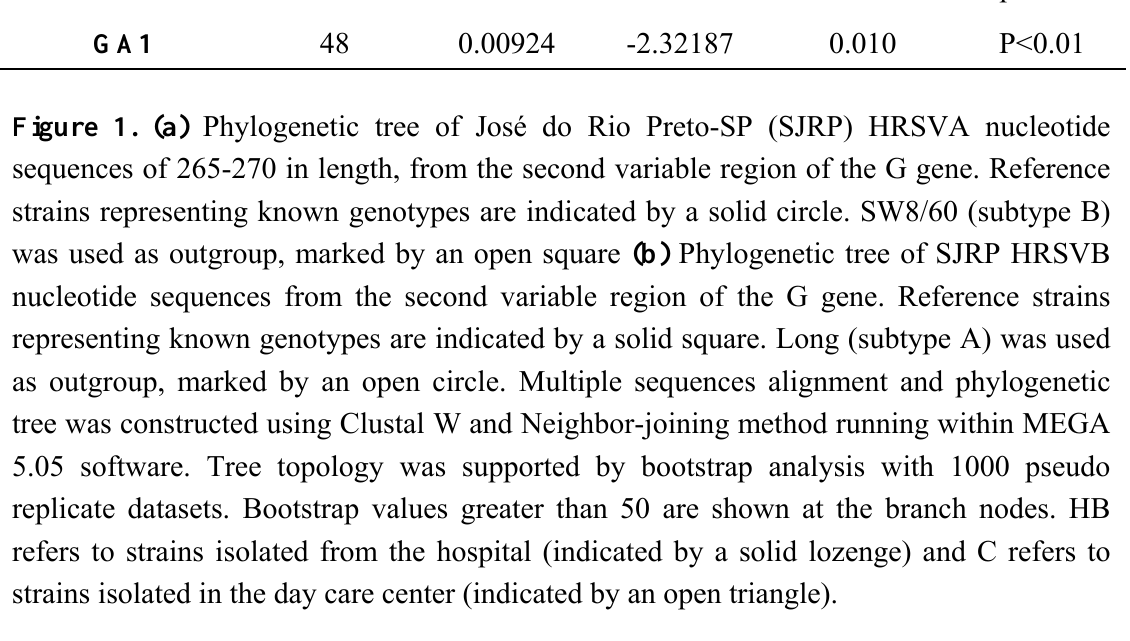
Figure 1. (a) Phylogenetic tree of José do Rio Preto-SP (SJRP) HRSVA nucleotide sequences of 265-270 in length, from the second variable region of the G gene.